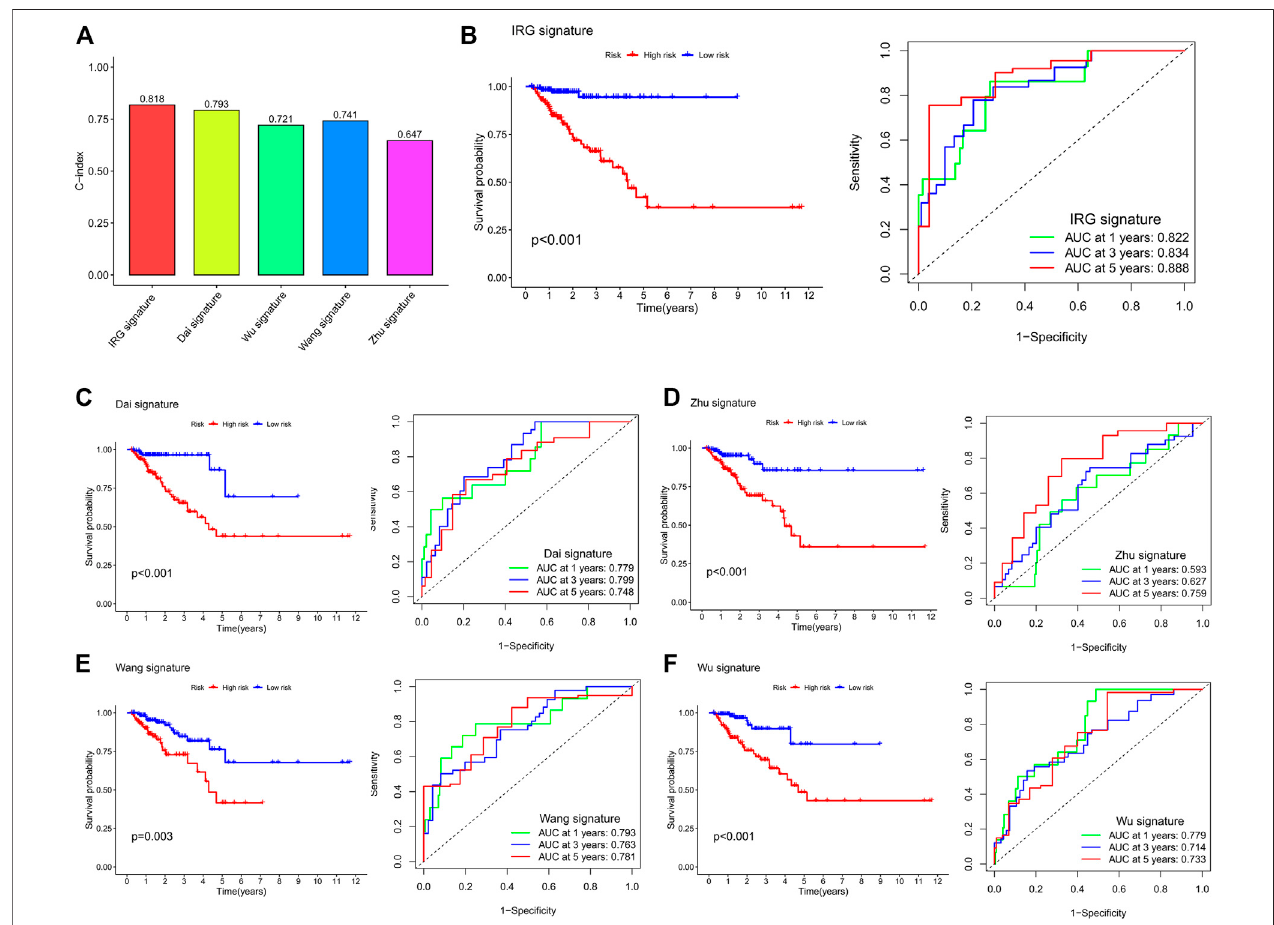
FIGURE8| ComparisonoftheIRGsignaturewithpreviouslyidenti fi edprognosticmodels. (A) TheC-indexoftheIRGsignatureandpreviouslyidenti fi edprognostic models. (B) Kaplan – Meiersurvival curve and ROC curve oftheIRG signature. (C) Kaplan – Meier survivalcurveand ROCcurve ofDai et al. ’ ssignature. (D) Kaplan – Meier survival curve and ROC curve of Zhu et al. ’ s signature. (E) Kaplan – Meier survival curve and ROC curve of Wang et al. ’ s signature. (F) Kaplan – Meier survival curve and ROC curve of Wu et al. ’ s signature. The survival curve is used to analyze the difference in prognosis between the low- and high-risk groups, and the AUC value of the ROC curve is used to evaluate the predictive